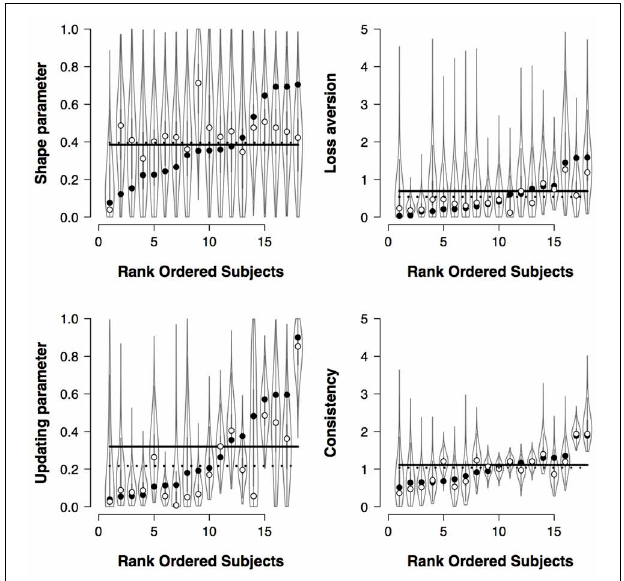
FIGURE A4 | Recovery of individual and group-level parameters of the PVL-Delta model. Data of 30 participants completing a 100-trial IGT. The dotted lines represent the modes of the group-level posteriors and the unfilled dots the modes of the individual-level